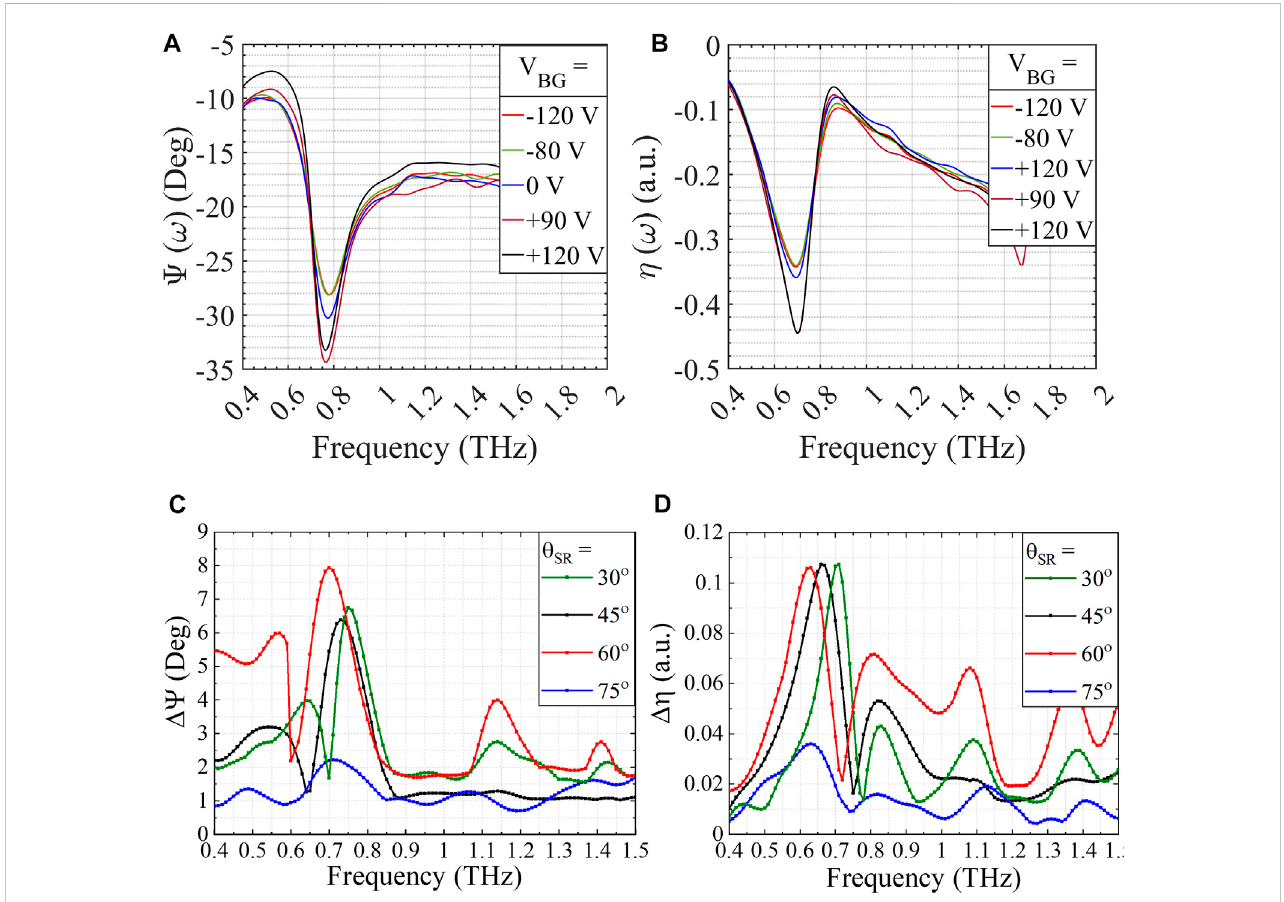
FIGURE 7 OA (A) and ellipticty ratio (B) at different biasing conditions when θ SR = 30 o and Φ AZ = − 30 o and +60 o . Active modulation depths of OA (C) and CD (D) for various θ SR angles. These values have been calculated by considering only the fi rst temporal